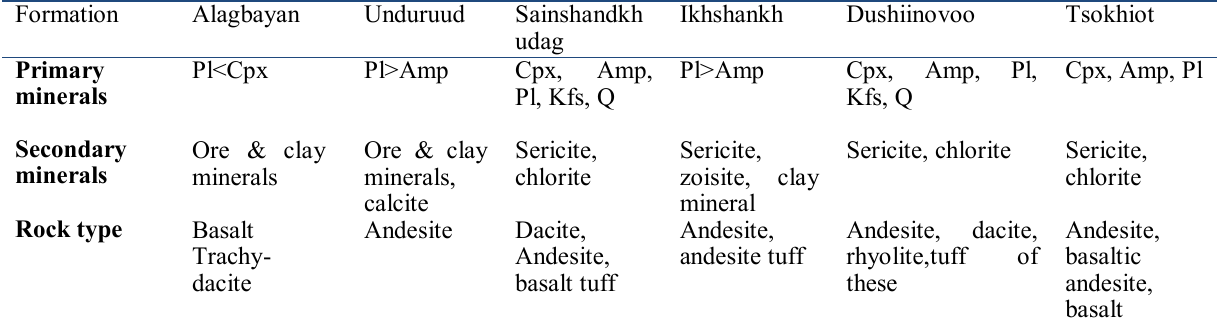
Table 1. Petrographical features of volcanogenic rocks of the Mandakh area